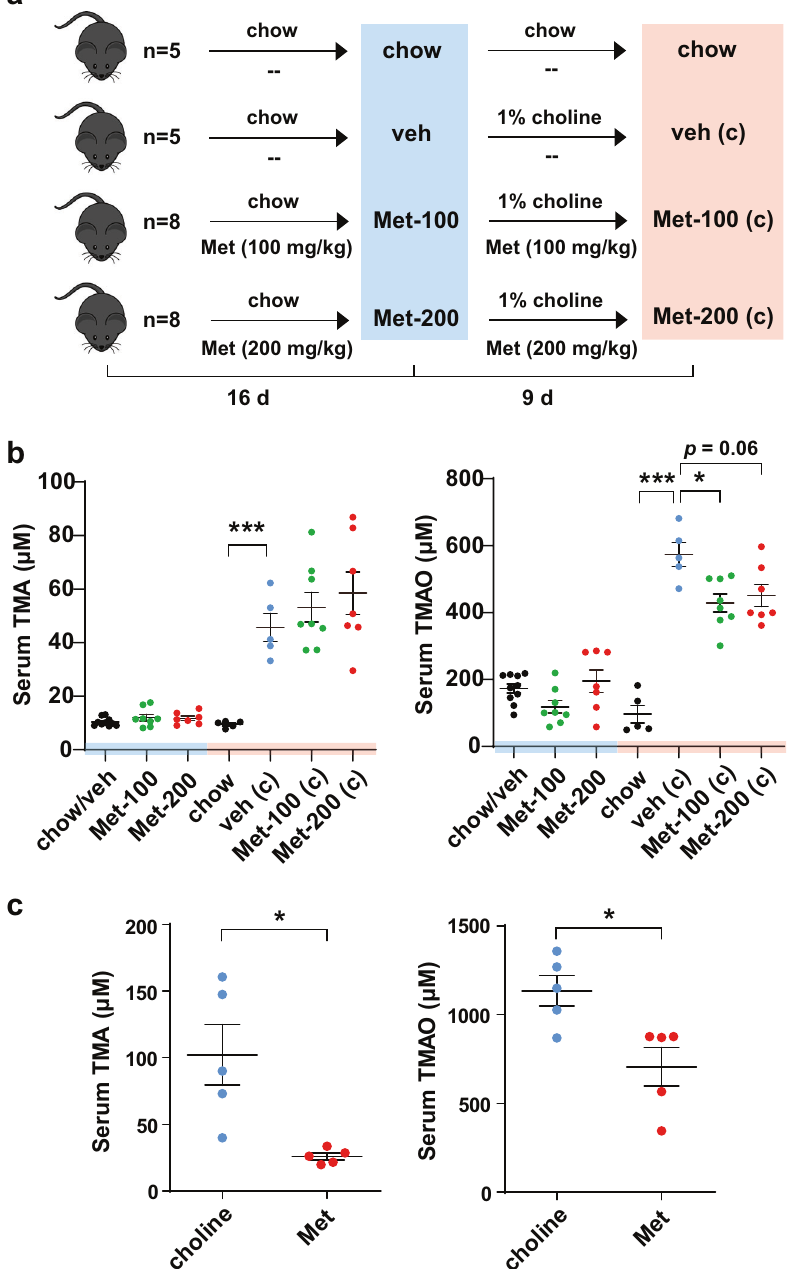
Fig. 1 The effects of metformin on serum TMA and TMAO levels in C57BL/6J mice under chow or choline diet. a , b Female C57BL/6J mice were fed chow with or without 100 mg/kg metformin (Met-100) or 200 mg/kg metformin (Met-200) for 16 days, then fed 1% choline diet with or without metformin (veh (c), Met-100 (c), Met-200 (c)) for another 9 days. Mice administration as illustrated in schematic diagram ( a ). TMA and TMAO levels were detected at indicated time points by HPLC-MS/MS ( b ). veh/veh (c), n = 5; chow, n = 5; Met-100/Met-100 (c), n = 8; Met- 200/Met-200 (c), n = 8. c 2% choline fed C57BL/6J mice were applied to evaluate the effects of metformin on TMA and TMAO levels. C57BL/6J mice were initially fed on chow diet with or without 200 mg/kg metformin for 6 weeks and sequentially converted to 2% choline diet for another 3 weeks. Serum TMA and TMAO levels were determined. n = 5 for each group. Values are presented as means ± SEM (* p < 0.05, *** p < Akkermansia decrease in T2D patients, and metformin treatment may negatively correlated with TMAO level. On the contrary, the relative reverse their relative abundance [2, 19]. Recent studies have also abundance of Lachnoclostridium , Ruminiclostridium and no_rank_- shown that oral administration of Akkermansia muciniphila , a well- Lachnospiraceae were increased signi fi cantly after choline diet and documented mucin-utilizing species in this genus, signi fi cantly reversed by metformin, which exhibited positive correlation with improved insulin sensitivity and reduced cholesterol levels in obese TMAO level (Fig. 2c, Supplementary Fig. 2c). Consistently, growing human volunteers [20]. evidence suggest that the abundance of genera Bi fi dobacterium and